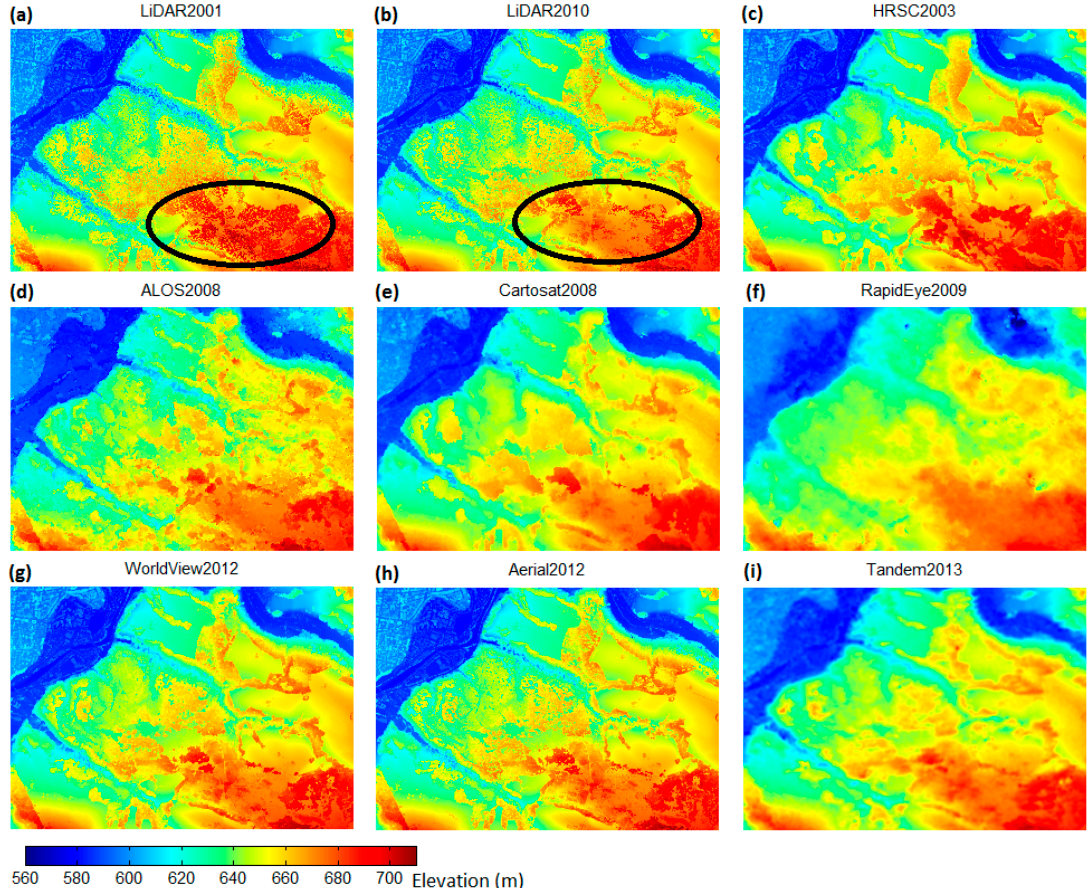
Figure 2. DSMs generated from three active systems (LiDAR2001 ( a ), LiDAR2010 ( b ), TanDEM-X2013 ( i )) and six passive, optical systems (HRSC2003 ( c ), ALOS2008 ( d ), Cartosat2008 ( e ), RapidEye2009 ( f ), WorldView2012 ( g ) and Aerial2012 ( h )), the ellipses in ( a , b ) mark the region that was destroyed by the storm Kyrill in 2007.